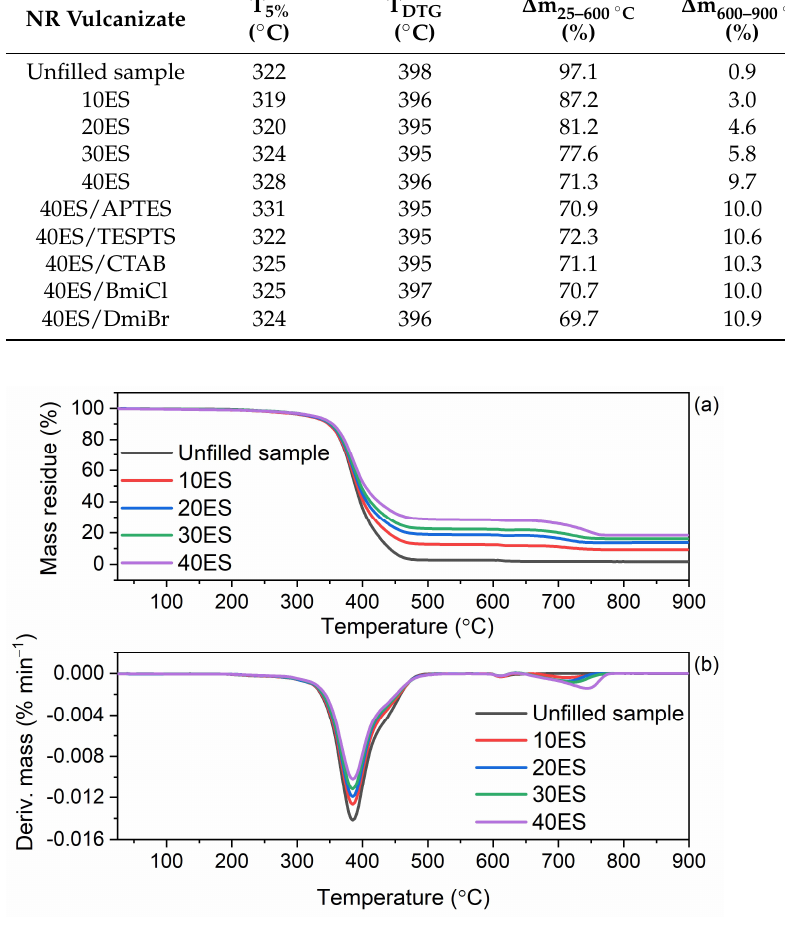
Figure 11. TG and DTG curves of the NR vulcanizates containing different amount of ground egg- shells: ( a ) TG curves; ( b ) DTG curves.